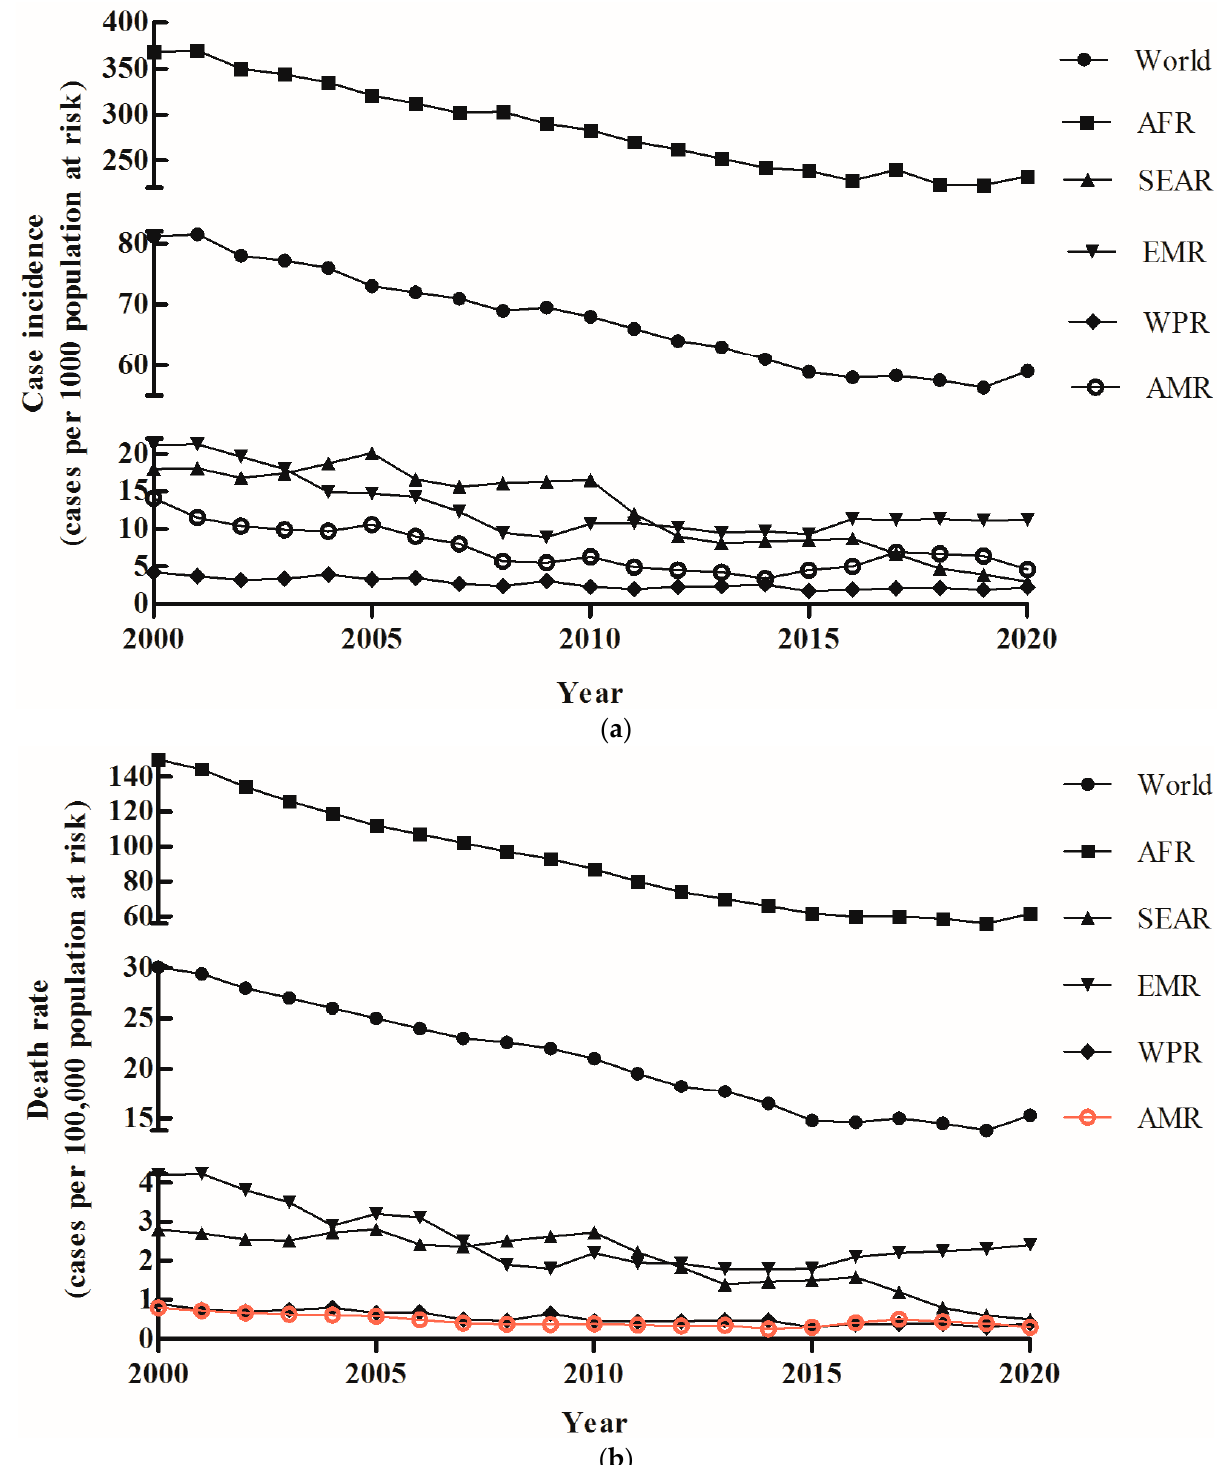
Figure 3. Geographic distribution of the incidence rate ( a ) and death rate ( b ) of malaria globally during 2000–2020.